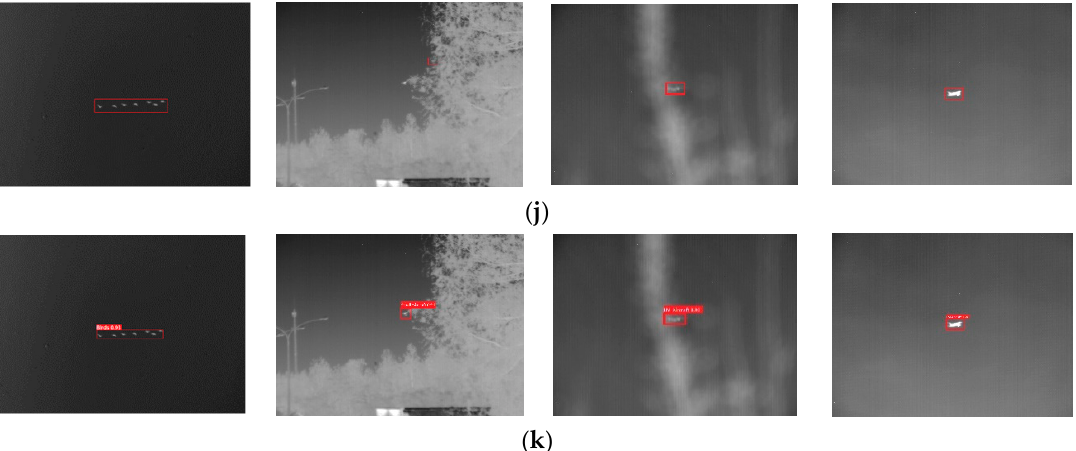
Figure 12. Detection results of infrared small targets with nine different algorithms on the OEDD. ( a ) Original images; ( b ) 3D visualization of the images; ( c ) YOLO V3; ( d ) YOLO V4-TinI; ( e ) faster R-CNN; ( f ) RFBnet; ( g ) TCTHR; ( h ) ISTDet; ( i ) IRSTD-GAN; ( j ) ALCNet; ( k ) the model we proposed.